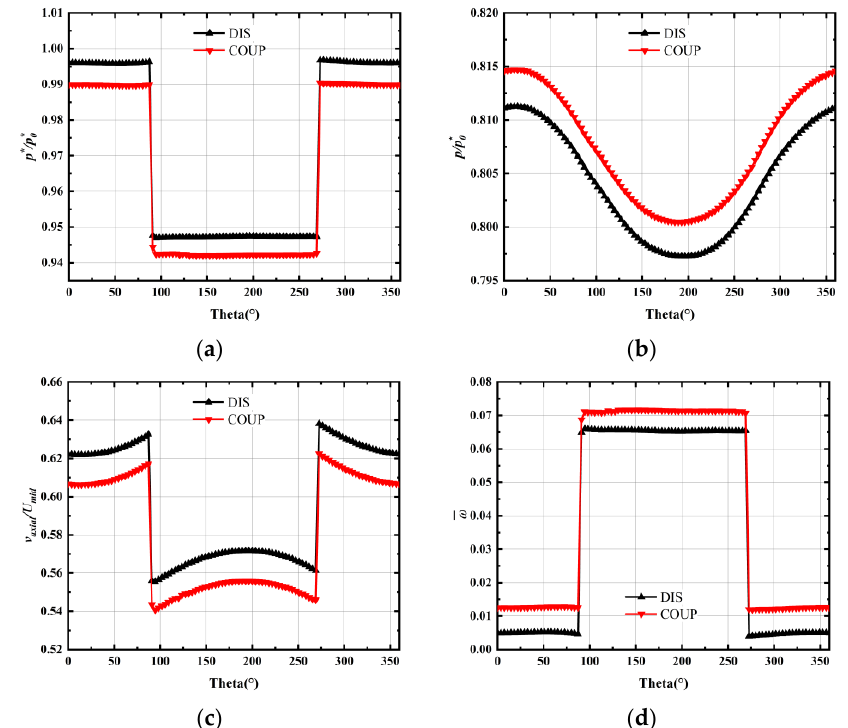
Figure 10. Time-averaged, circumferential distributions of different parameters in the AIP section (at 95% spanwise). ( a ) Total pressure coefficient; ( b ) static pressure coefficient; ( c ) axial velocity coefficient; ( d ) loss coefficient.